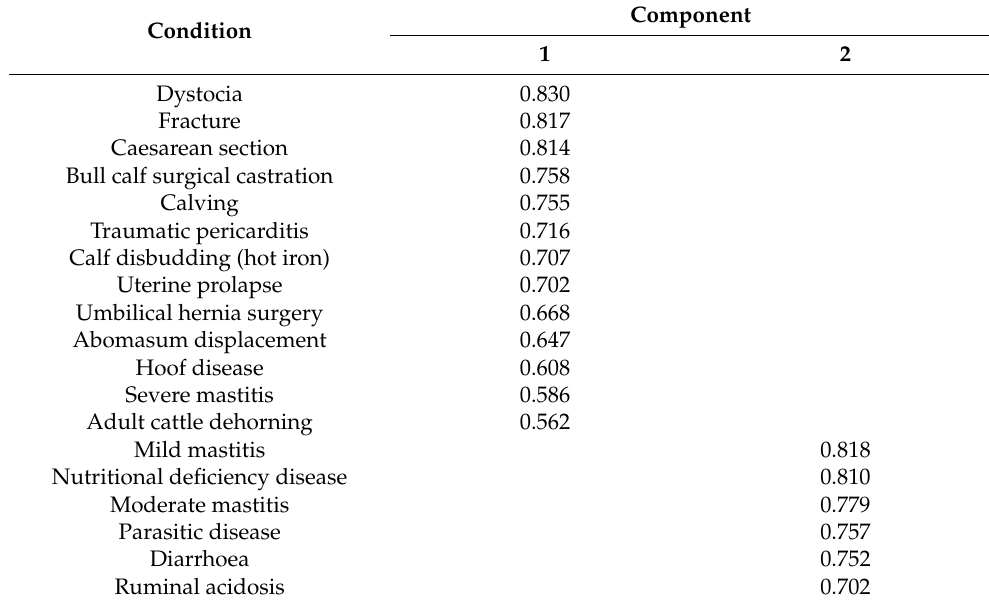
Table 3. Rotated component matrix for the first two principal components after eliminating the cor- relation coefficients less than 0.48 1 .